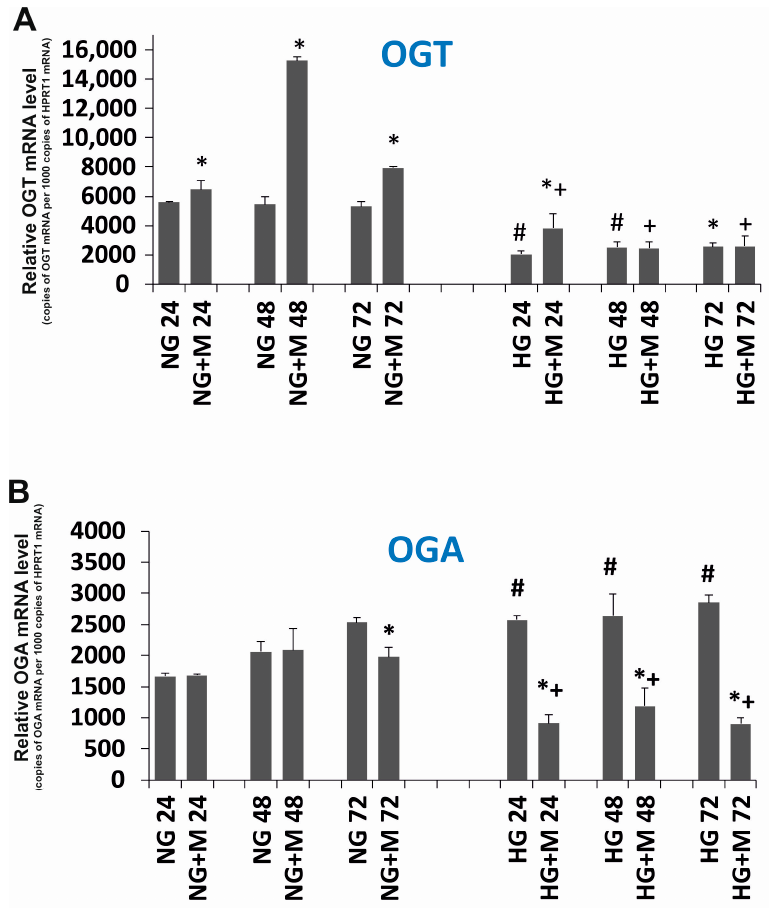
Figure 5. Relative ( A ) OGT (O-linked β - N -acetlyglucosamine transferase); ( B ) OGA (O-GlcNAcase) mRNA expression detected after 24, 48, and 72 h in metformin-treated and untreated ovarian cancer cell line SKOV-3 cultured in NG and in HG. NG—cells cultured in normoglycemia, NG + M—cells cultured in normoglycemia and treated with metformin, HG—cells cultured in hyperglycemia, HG + M—cells cultured in hyperglycemia and treated with metformin, (*) Statistically significant differences between the cells exposed to metformin in comparison to unexposed cells at the same time points, p < 0.05; (#) statistically significant differences between cells cultured in HG in comparison to those cultured in NG at the same time-points p < 0.05; (+) statistically significant differences between metformin-treated cells in HG in comparison to metformin-treated cells cultured in NG at the same time points, p < 0.05.